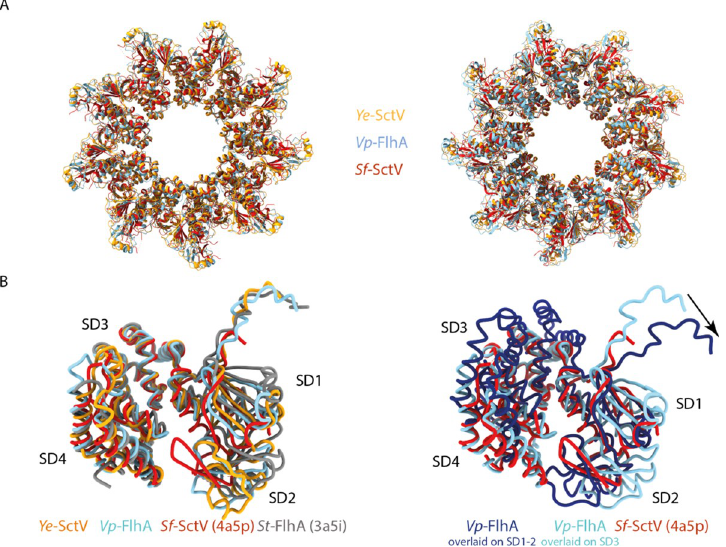
Fig 3. The cryo-EM structures of Ye-SctV and Vp-FlhA are in the open state. a. Overlay of the nonameric rings of the cytoplasmic domains of Ye-SctV and Vp-FlhA with the crystal structure of the Sf -SctV nonameric ring (PDB: 4A5P). b. Overlay of a single subunit of Ye -SctV and Vp -FlhA with St -FlhA in the open state (grey, PDB: 3A5I) and Sf - SctV in the closed state (red, PDB: 4A5P). c. Overlay of Vp -FlhA (light blue) on the SD3 domain of Sf -SctV (red) and overlay (dark blue) on the SD1 and SD2 domains of Sf -SctV illustrating the movement of the linker (arrow) as the protein changes from the open to the closed state.